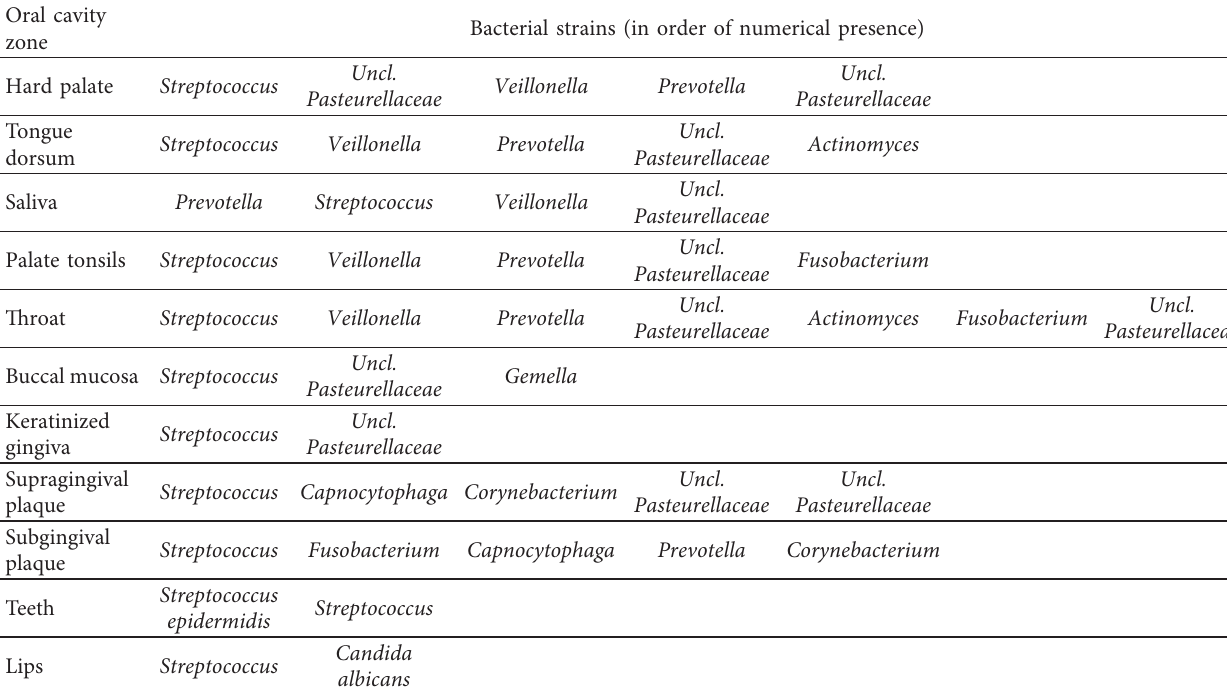
Table 1: Bacterial strains dominant in the oral cavity where the important role of Streptococcus is evident (from the work of Jia et al. [23]